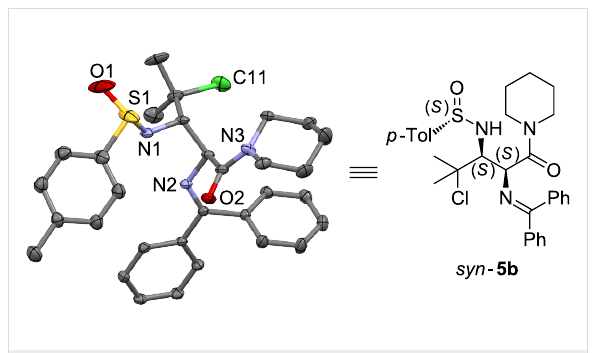
Figure 2: Crystal structure of syn - γ -chloro- α , β -diaminocarboxylamide syn- 5b .